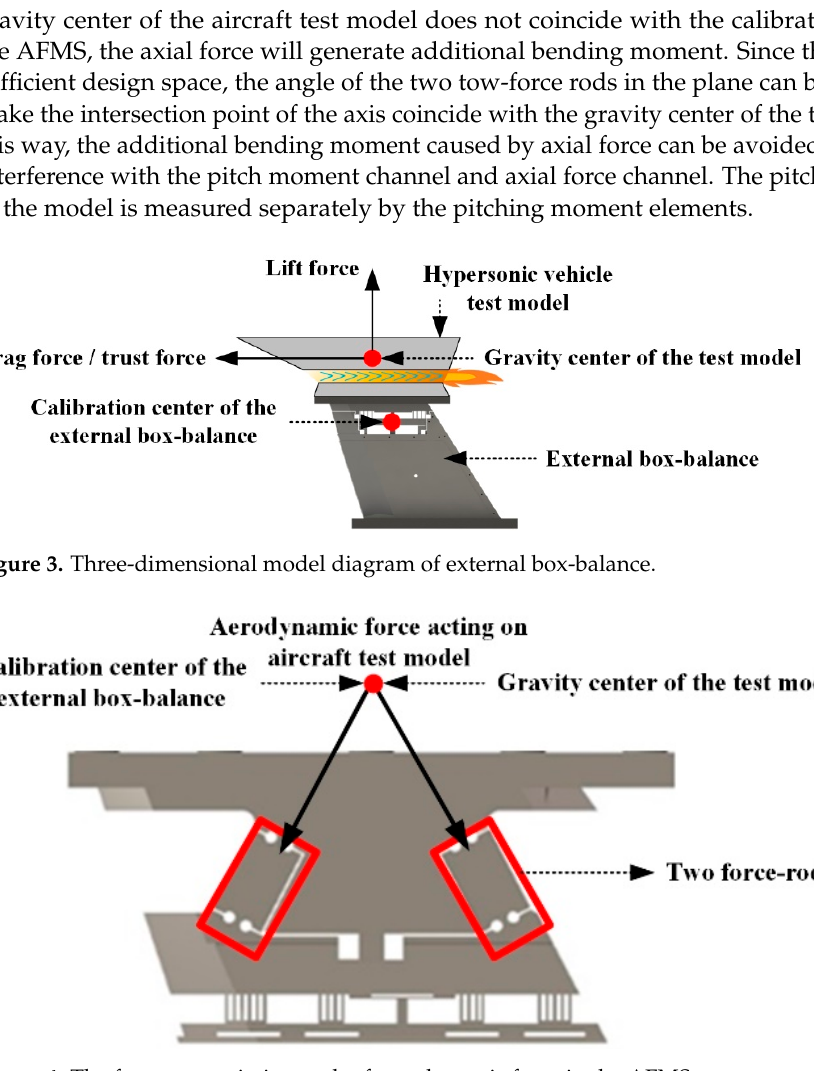
Figure 4. The force transmission path of aerodynamic force in the AFMS.